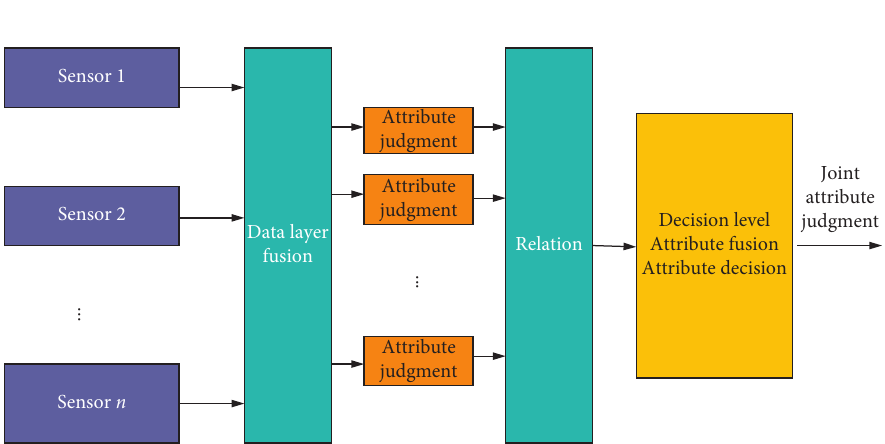
Figure 2: Feature layer fusion structure.